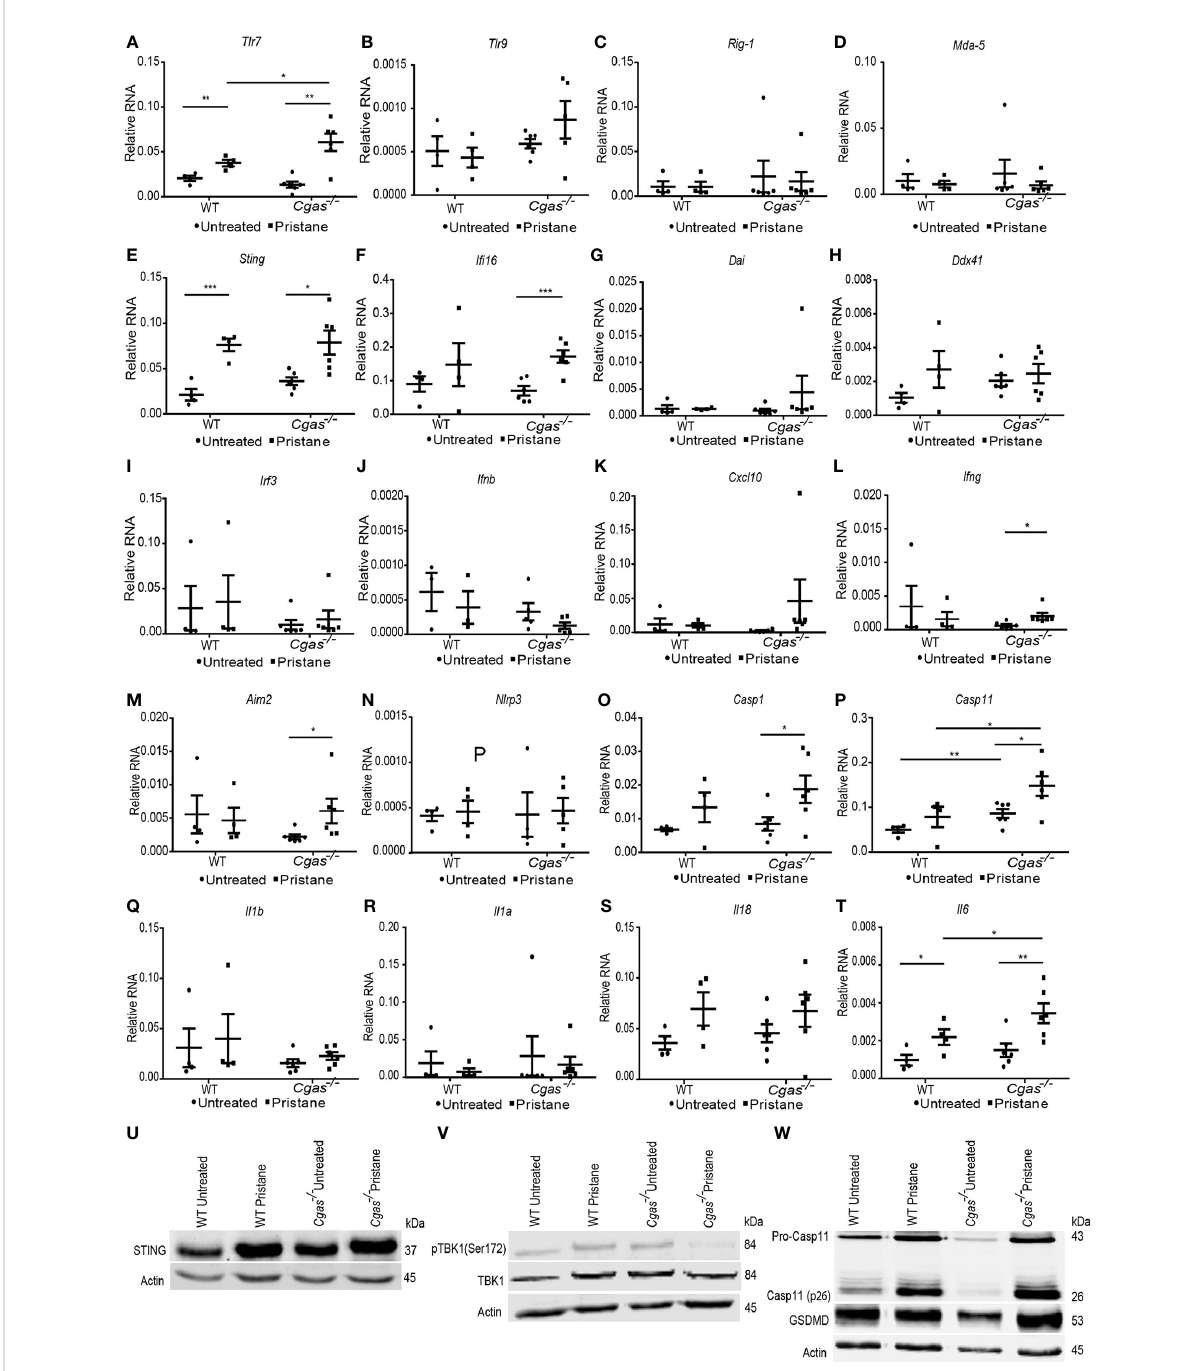
FIGURE 5 Inhibition of cGAS increases the expression of Caspase 11 but not phosphorylation TBK1 in the lungs of pristane-induced lupus mice. (A – L) The relative RNA expression (normalized to actin) of (A) Tlr7 , (B) Tlr9 , (C) Rig1 , (D) Mda5 , (E) Sting , (F) I fi 16 , (G) Dai , (H) Ddx41 , (I) Irf3 , (J) Ifnb , (K) Cxcl10 , (L) Ifng , (M) Aim2 , (N) Nlrp3 , (O) Casp1 , (P) Casp11 , (Q) Il1b , (R) Il1a , (S) Il18, and (T) Il6 from the lungs of WT and Cgas -/- mice at 8 months after pristane injection (n = 4-6 per group). (U – W) Western blot analysis of (U) STING, (V) phosphorylation of TBK1 (Ser172), and (W) caspase-11 and gasdermin D from the lungs of WT and Cgas -/- mice at 8 months after pristane injection (representative blot, n = 3). Data are shown as the mean ± SEM. *p < 0.05, **p < 0.01, *** p <